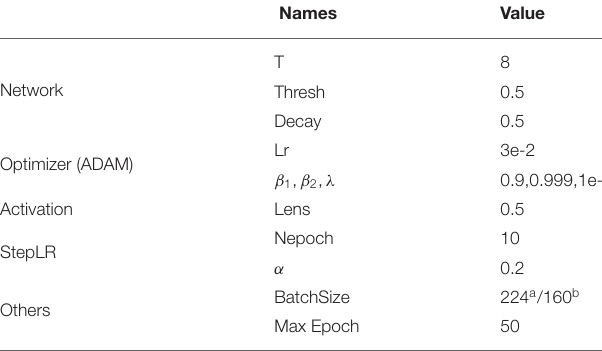
TABLE 3 | Hyper-parameter